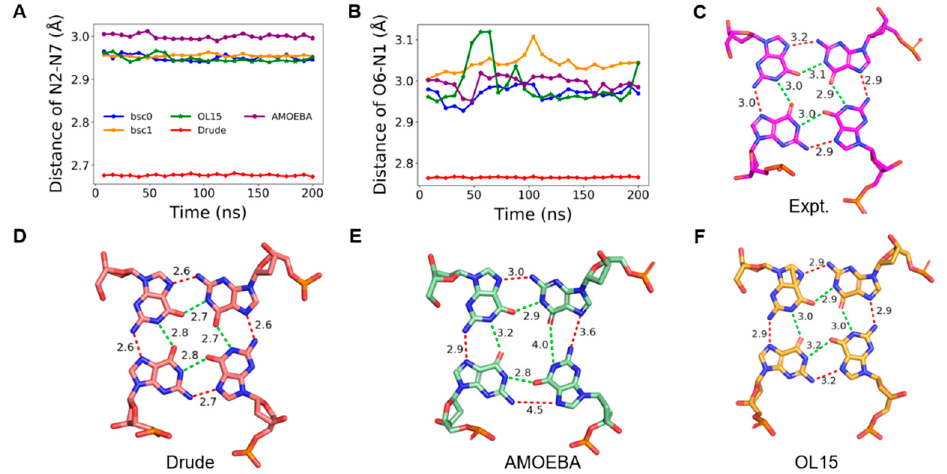
Figure 4. ( A ) and ( B ) are changes of hydrogen bond lengths in tetrad 1 during the MD simulation of K ‐ GQ. ( C )–( F ) are typical structures of tetrad 1 in experiment, and MD simulation with Drude, AMOEBA, and OL15, respectively. ( A ) and ( B ) share the same figure legend.